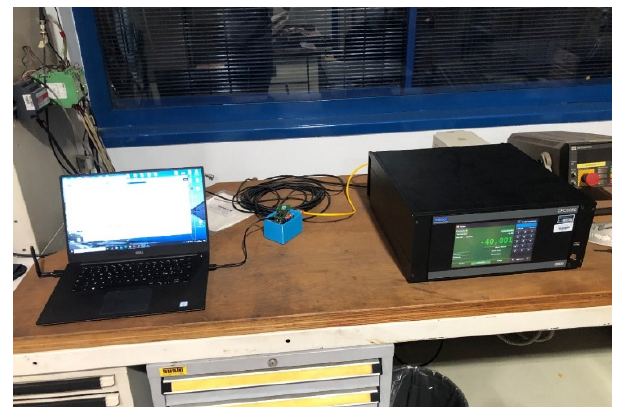
Figure 4. Calibration test bench.